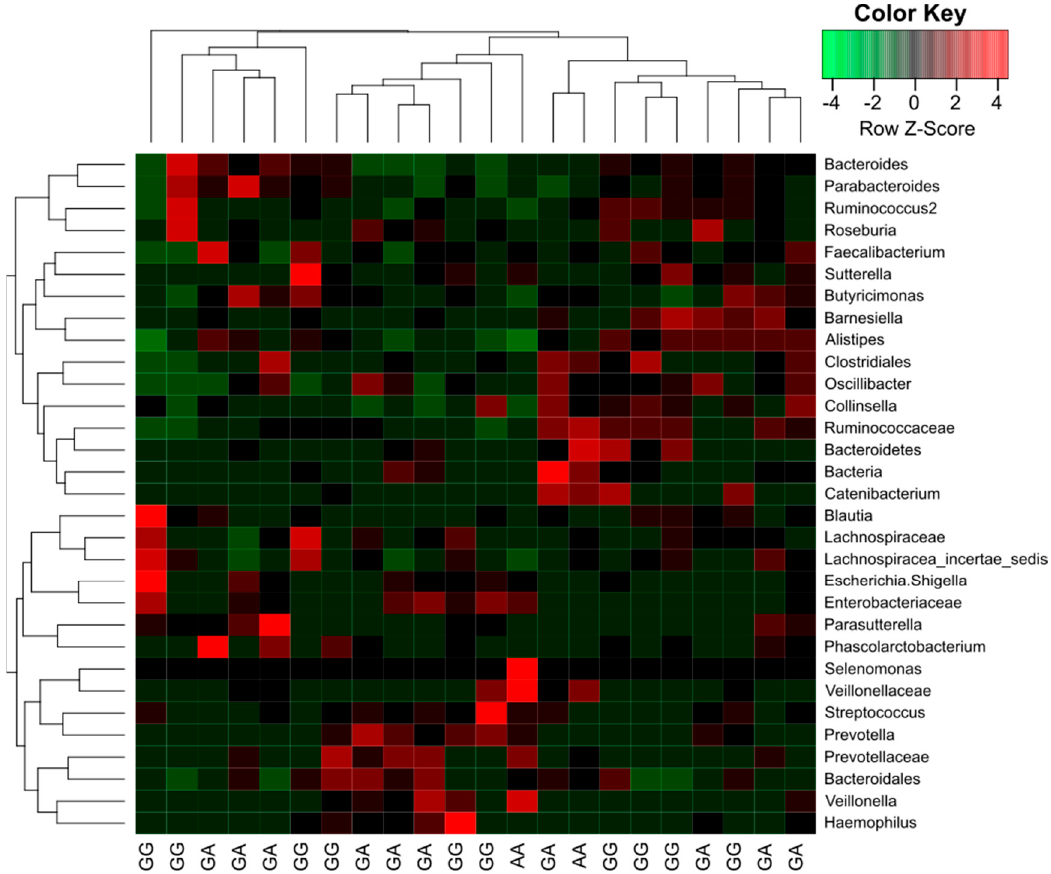
Figure 6. Associations between changes in microbial composition and gene FUT2 variants.